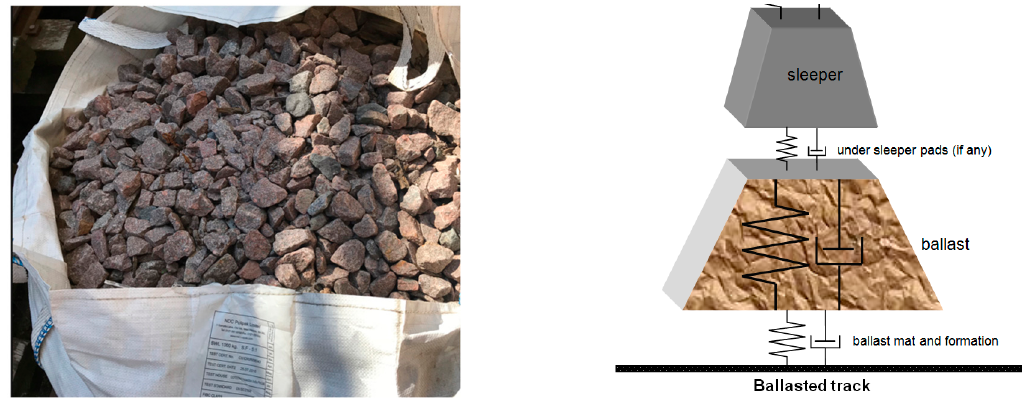
Figure 2. Natural ballast (left) and ballast idealization as spring-dashpot